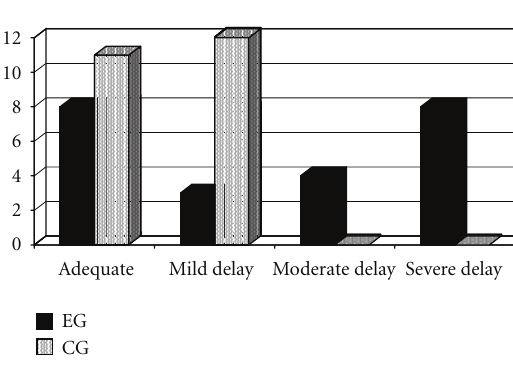
Figure 2: Cognitive evaluation outcomes of the experimental and control groups (EG: control group; CG: control group).